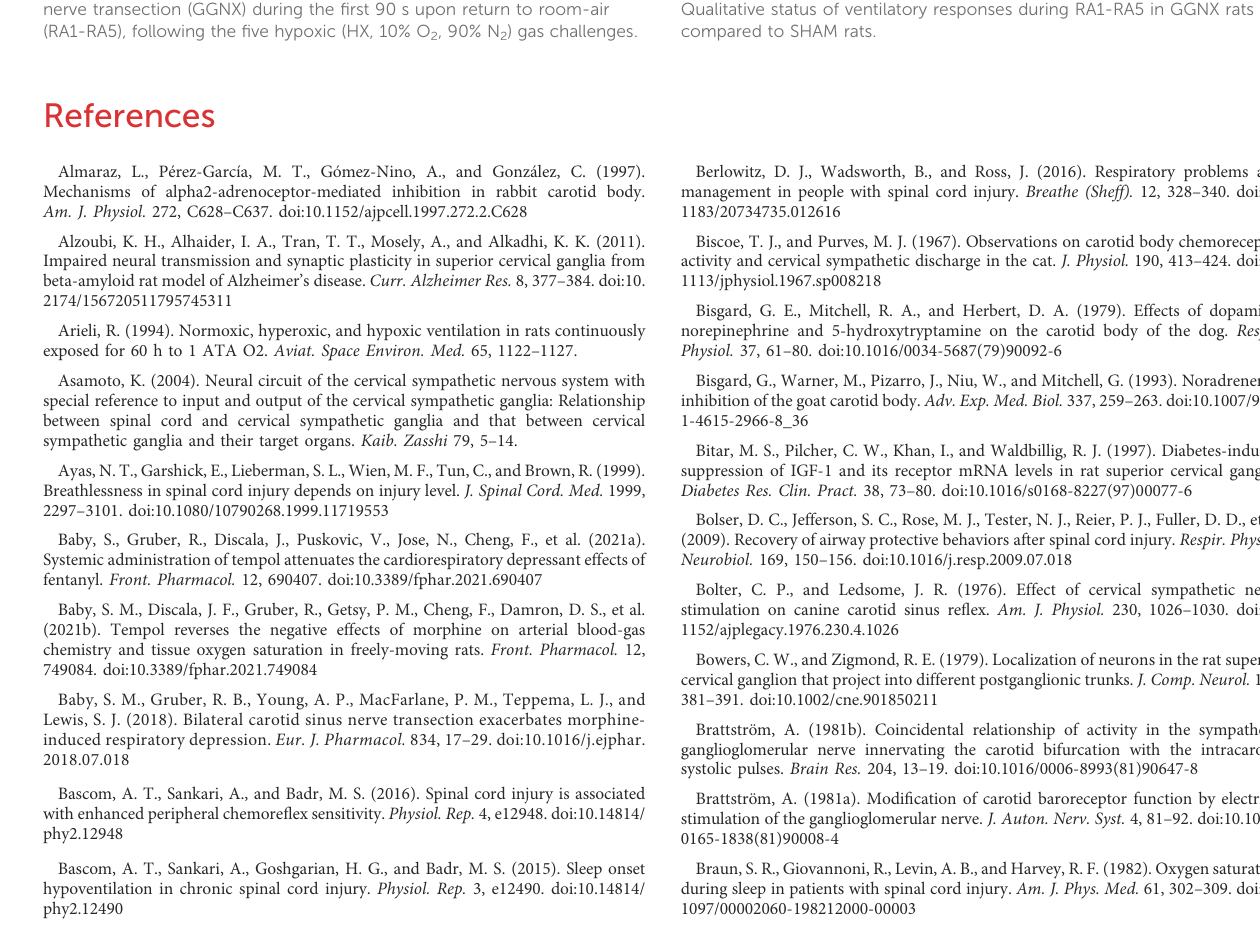
compared to SHAM rats.